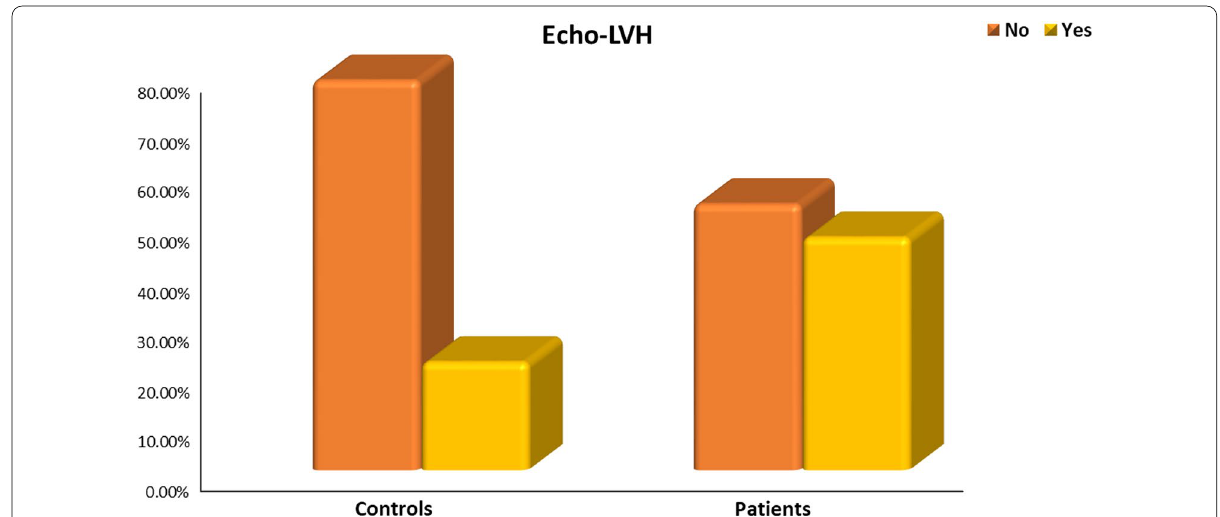
Fig. 1 Comparison between both groups in LVH